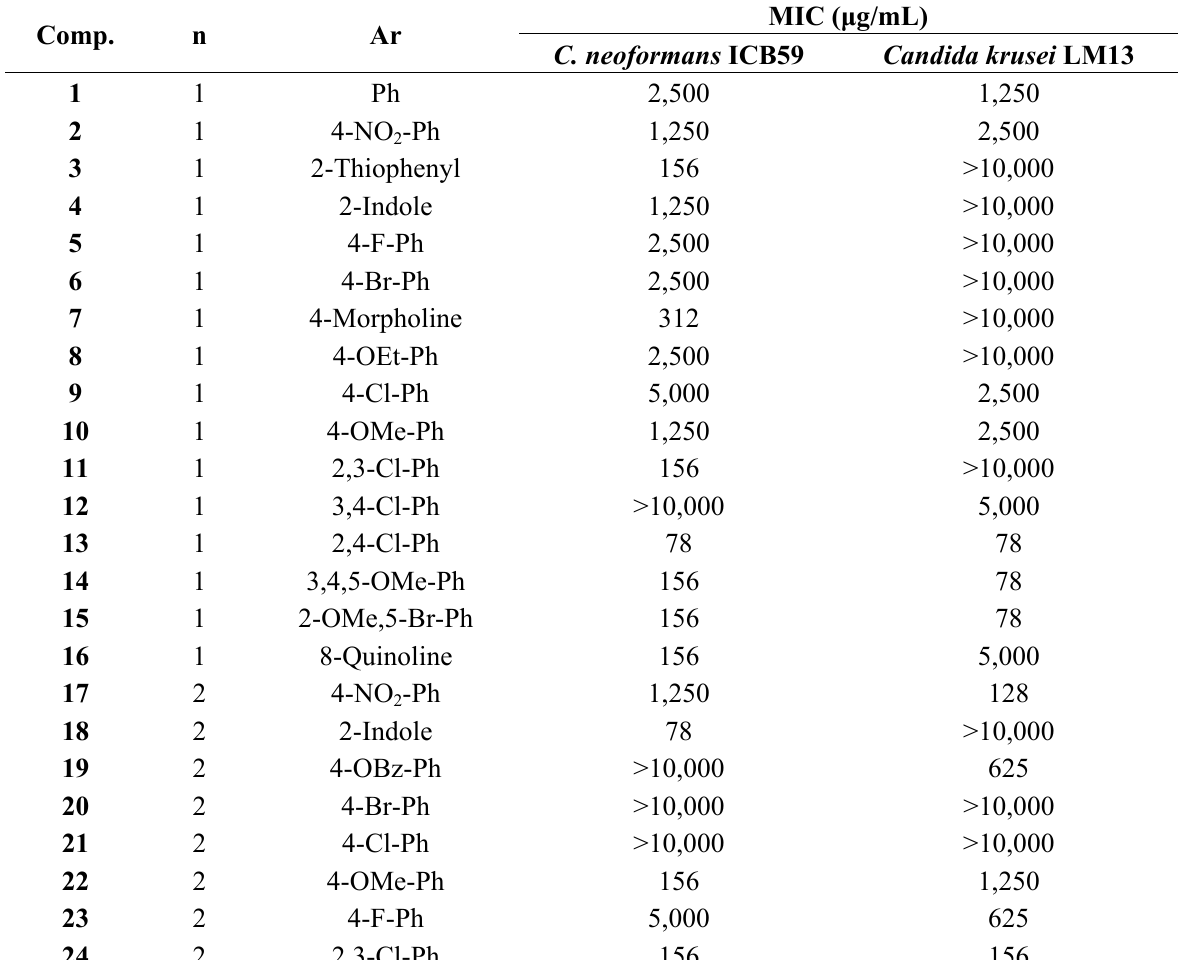
Table 1. Anti- Candida and anti- Criptococcus activities and chemical formulas of the studied 2-aminothiophene